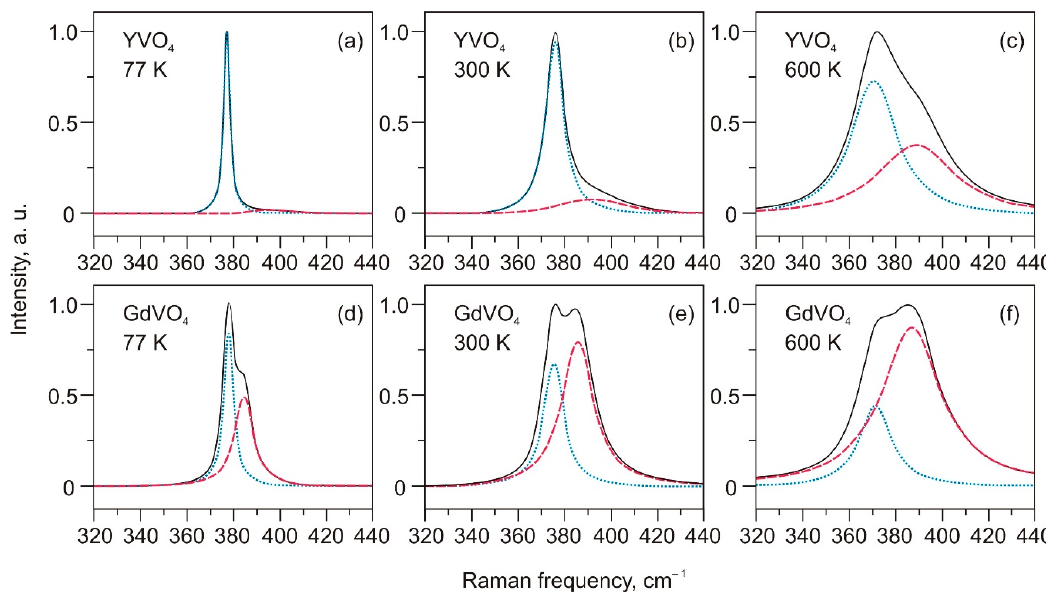
Figure 1. The bending mode ν 2 Raman line decomposed into two components, one of which (red dashed lines) is strongly dependent on temperature, in the Raman spectra of ( a – c ) YVO 4 and ( d – f ) GdVO 4 at various temperatures [19].